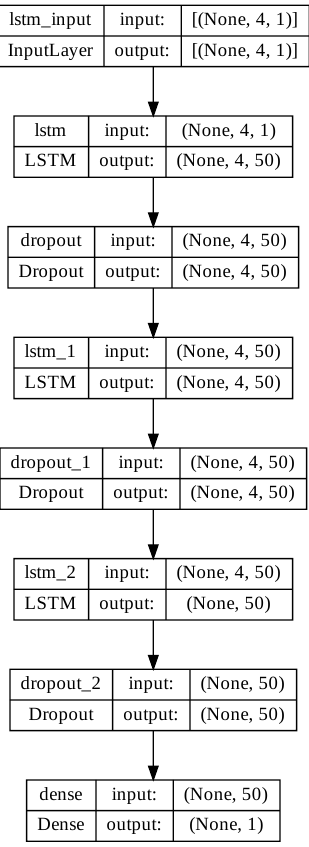
Figure 1. The multi-layer construction of the Long Short-Term Memory model. The numbers next to the layers indicate the dimensionality of the data. The com- monly used optimization method “Adam” (Adaptive Moment Estimation) was used [43]. “mean_squared_error” was used as a metric determining the effectiveness of the model [44]. Other metrics considered are “mean_absolute_error” and “binary_crossentropy” [44,45]. The mean square error is the average of the squares of the difference between the expected value and the result of a given trial (5).